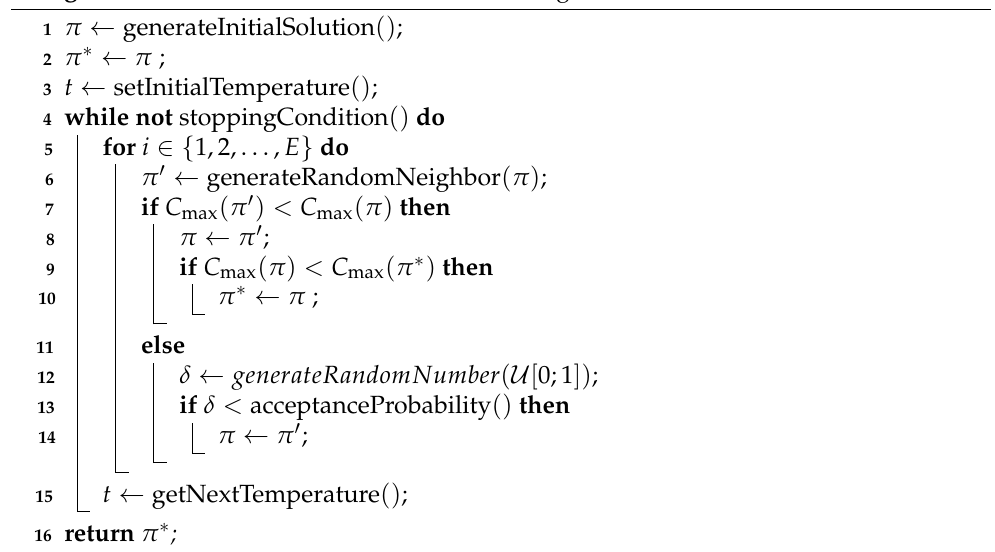
Algorithm 3: Outline of the simulated annealing